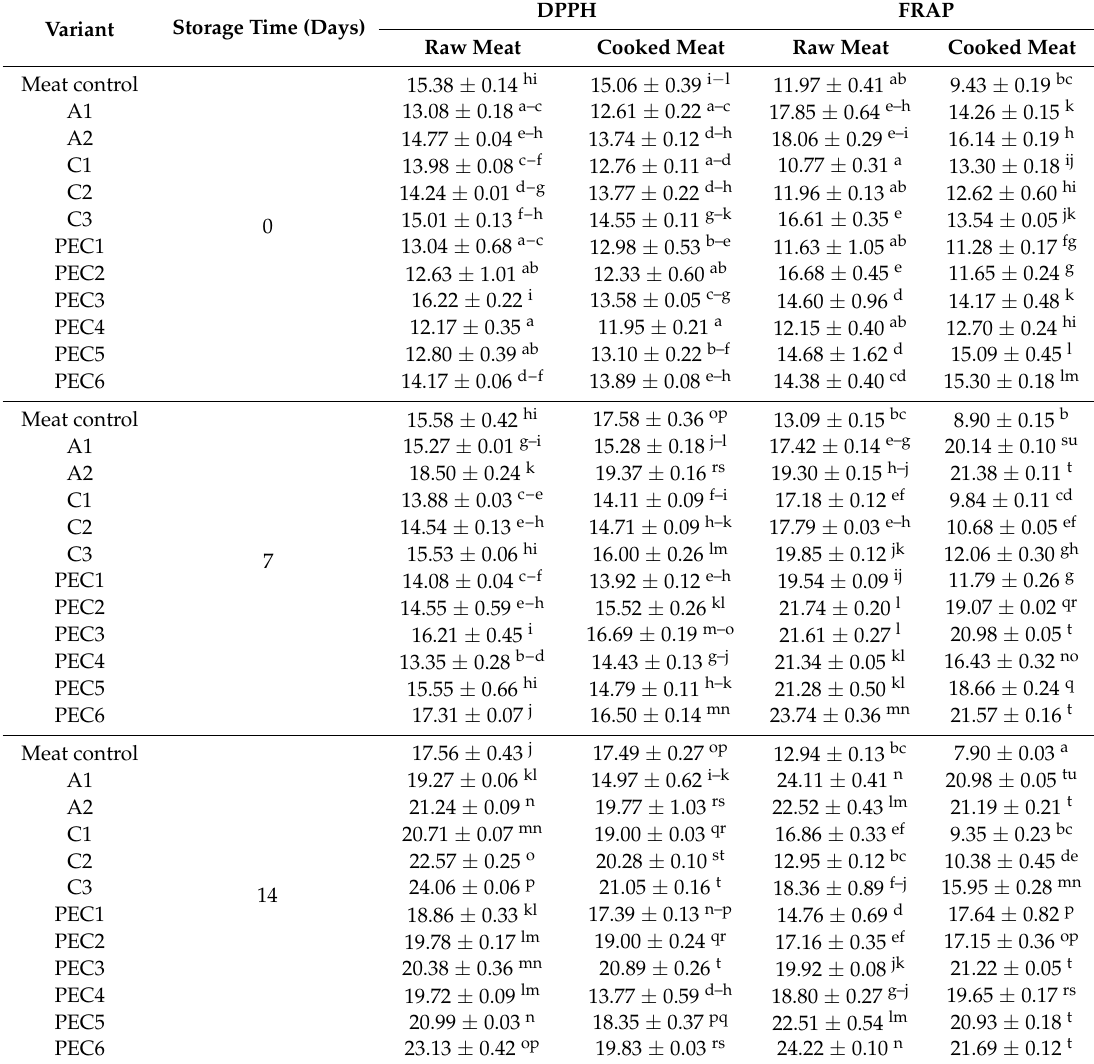
Table 1. Total antioxidant capacity (TAC) of raw and cooked pork meat covered/uncovered with sodium alginate, chitosan, and sodium alginate-chitosan polyelectrolyte complex during 0, 7, and 14 days of chill